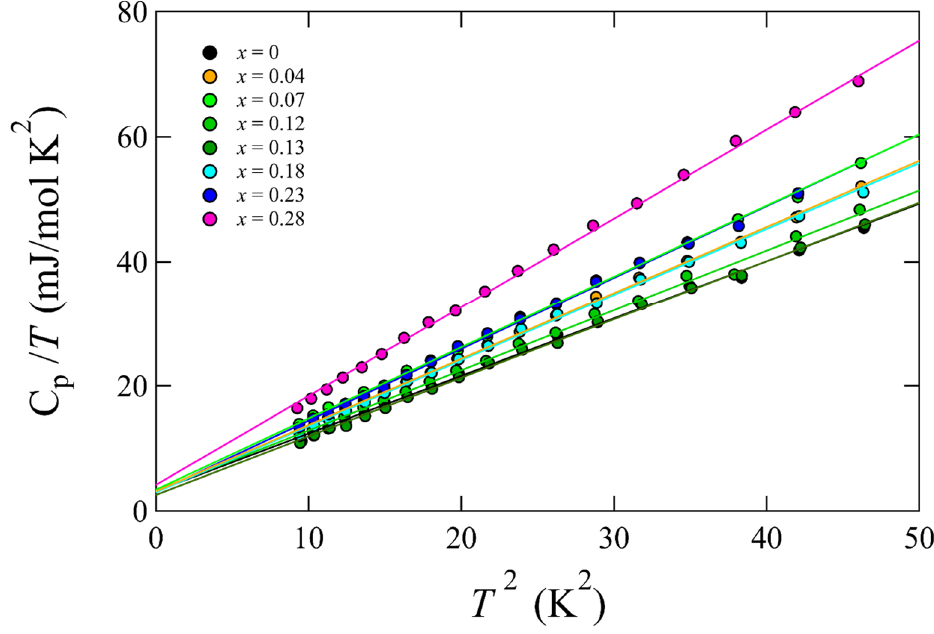
Table 2. Fitting parameters used in Figure 6.